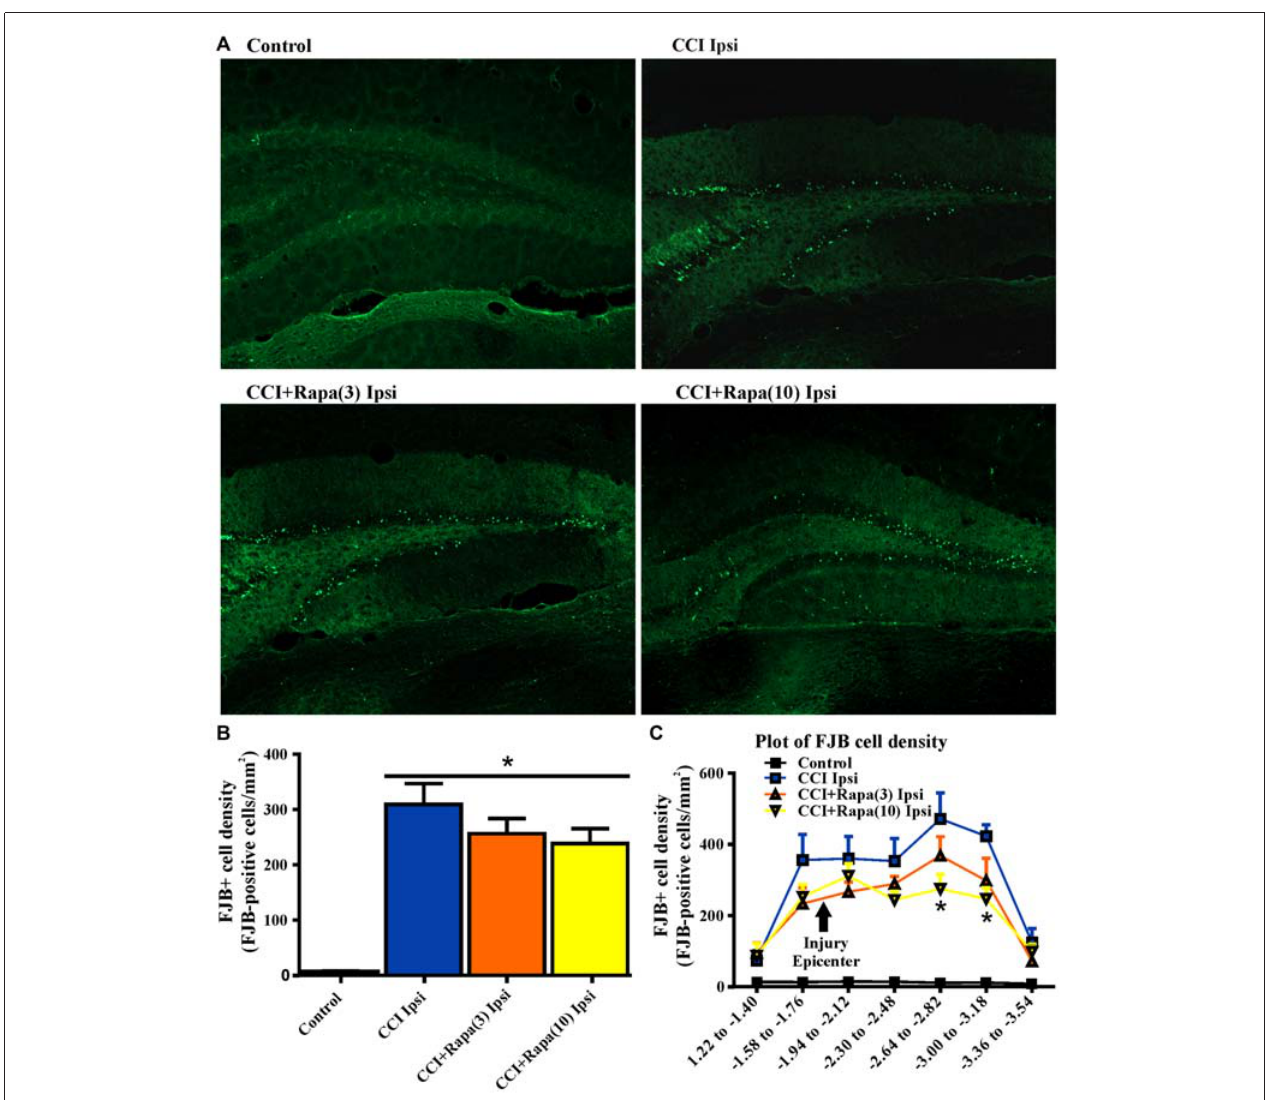
FIGURE 1 | Fluoro-Jade B labeling in dentate gyrus 3 days after control treatment, CCI or CCI with daily rapamycin administration . (A) Representative images of Fluoro-Jade B (FJB) labeling from four different groups: control, ipsilateral to CCI injury + vehicle (CCI Ipsi), ipsilateral to CCI injury + rapamycin at 3 mg/kg (CCI + Rapa(3) Ipsi), and ipsilateral to CCI injury + rapamycin at 10 mg/kg (CCI + Rapa(10) Ipsi). (B) Mean FJB labeling in control, CCI Ipsi, CCI + Rapa(3) Ipsi, and CCI + Rapa(10) Ipsi groups. FJB-positive cell density (cells/mm 2 ) was averaged across coronal slices from − 1.22 to − 3.52 mm from bregma. All CCI ipsilateral hemispheres exhibited increased FJB-positive cell density relative to controls. No significant difference was observed after CCI injury between vehicle- and rapamycin-treated mice. (C) FJB-positive cells/mm 2 as a function of distance from bregma along the septo-temporal axis of hippocampus. The CCI + Rapa(10) group exhibited reduced FJB-positive cell density only in a limited region of posterior hippocampus relative to CCI + vehicle treatment. Error bars indicate SEM; ∗ p <